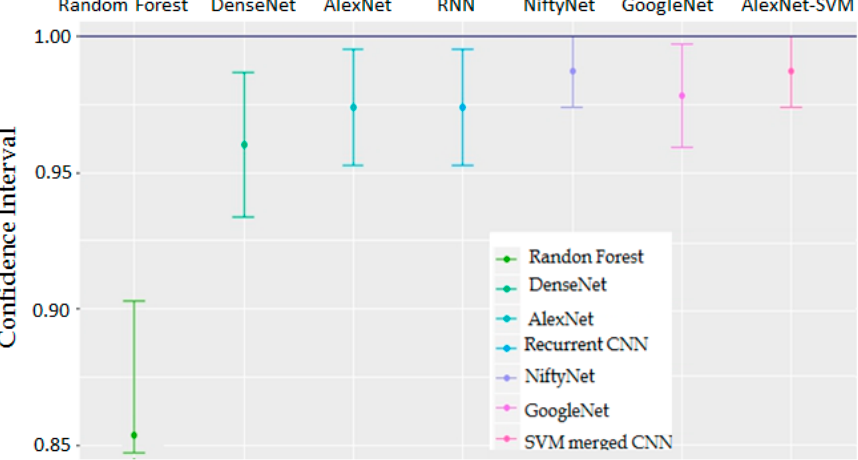
Figure 6. An intercomparison of the proposed method with the leading architectures using 95% CI.